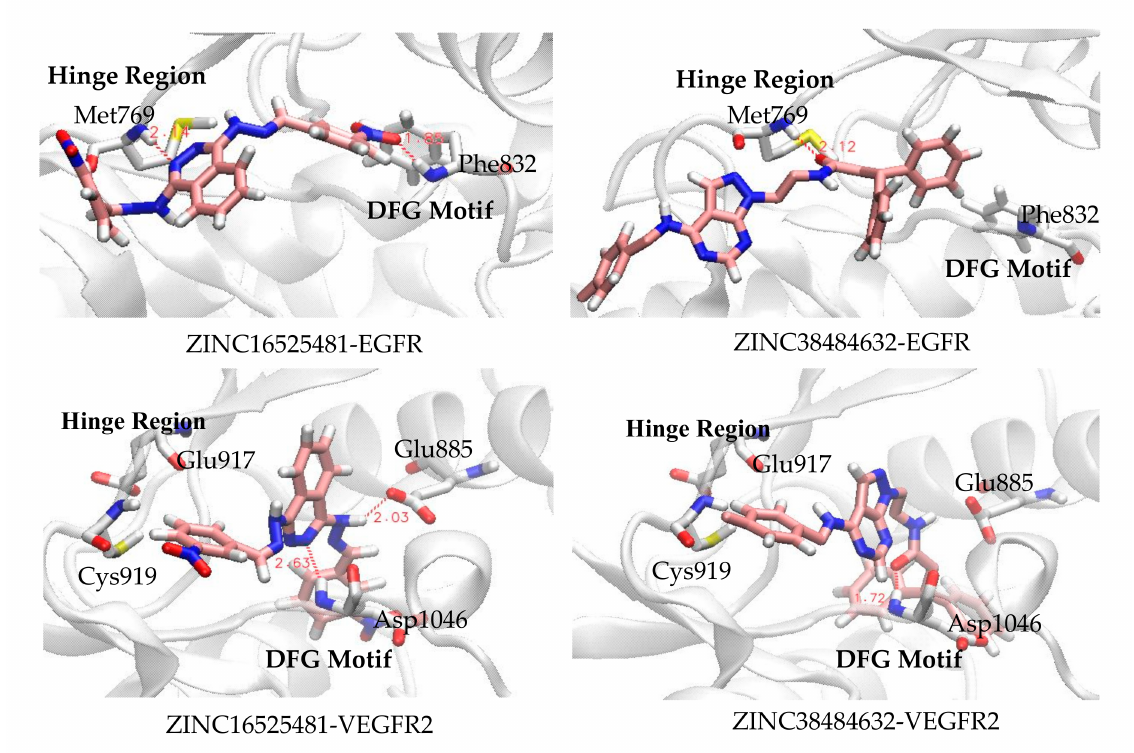
Figure 11. Binding mode of ZINC16525481 and ZINC38484632 to the ATP binding pocket of EGFR and VEGFR2 at 50